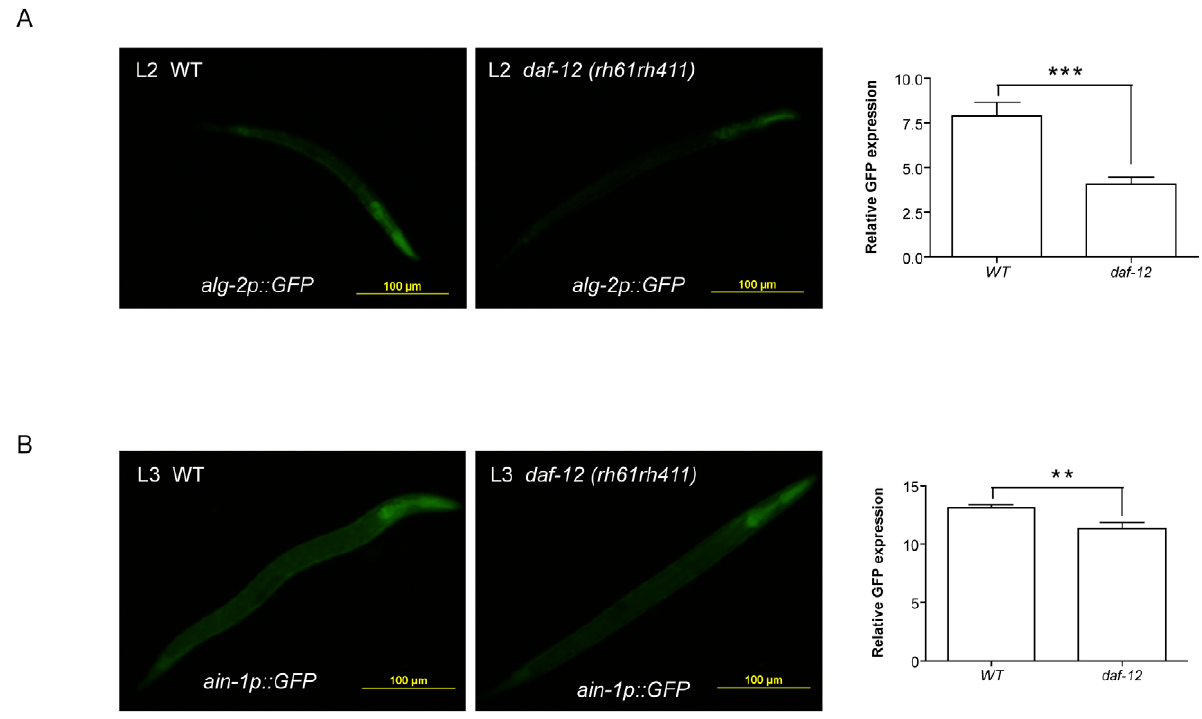
Figure 5. DAF-12 regulates expression of miRISC genes. ( A ) Image of alg-2p::GFP in WT or daf-12(rh61rh411) strains at the L2 stage (left). Graph showing alg-2p::GFP quantification in both strains (right) ( p , 0.0001). ( B ) Image of ain-1p::GFP in WT or daf-12(rh61rh411) strains at the L3 stage (left). Graph showing ain-1p::GFP quantification in both strains (right) ( p =0.002). P-values were determined by unpaired t-test.